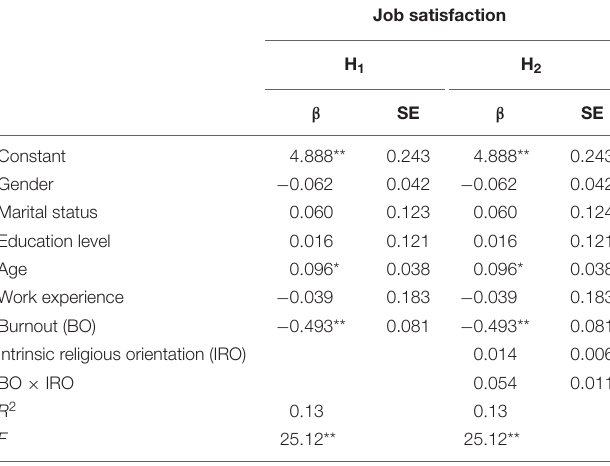
TABLE 5 | Output of robustness analysis for